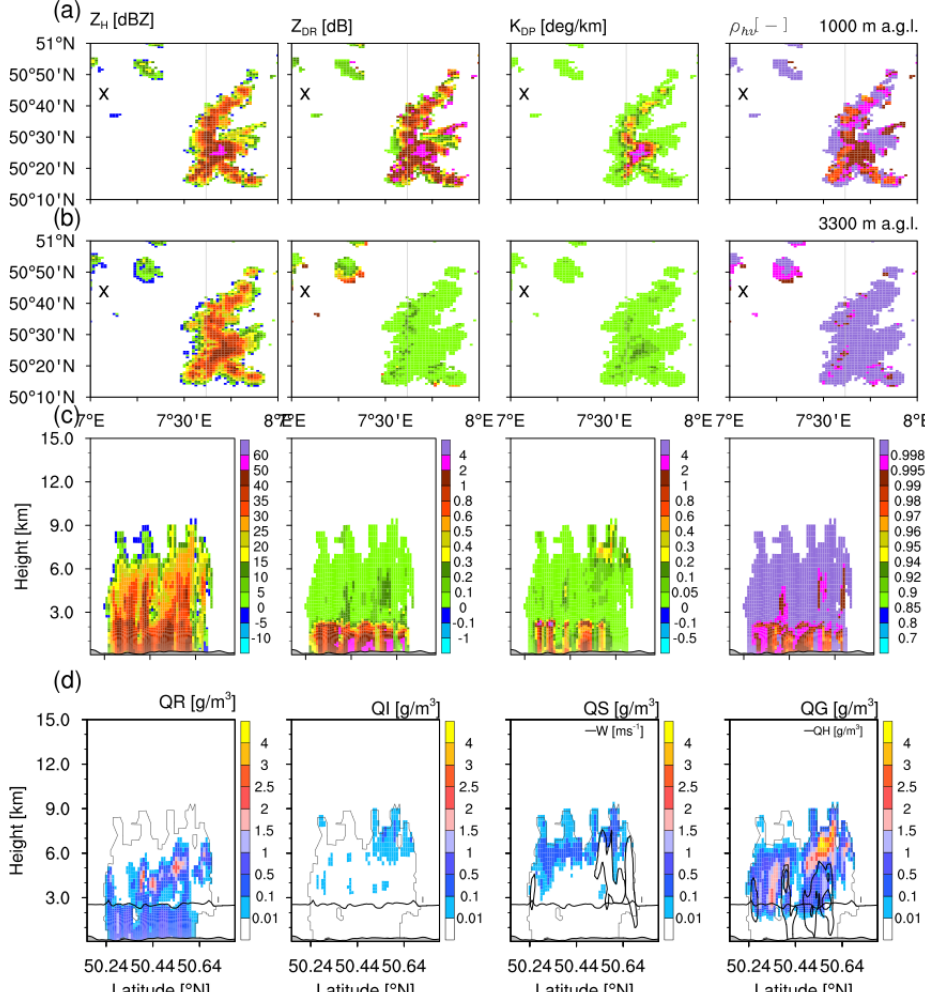
Figure 8. (a, b) Model-simulated horizontal reflectivity, differential reflectivity, specific differential phase and cross-correlation coefficient at low level (1000ma.g.l.) and near the melting layer (3300ma.g.l.) on 13 May 2016 at 10:50UTC. The “ × ” symbol refers to the BoXPol location. The solid grey line indicates the location of cross section. (c) Cross section of the same polarimetric variables. (d) Cross section of model-simulated hydrometeor density – Q R (rain), Q I (ice), Q S (snow), Q G (graupel) and Q H (hail). Also shown are the 0 ◦ C line (solid black line) indicating the melting layer, contours of vertical velocity [5, 40ms − 1 ] with Q S and contours of the Q H with Q